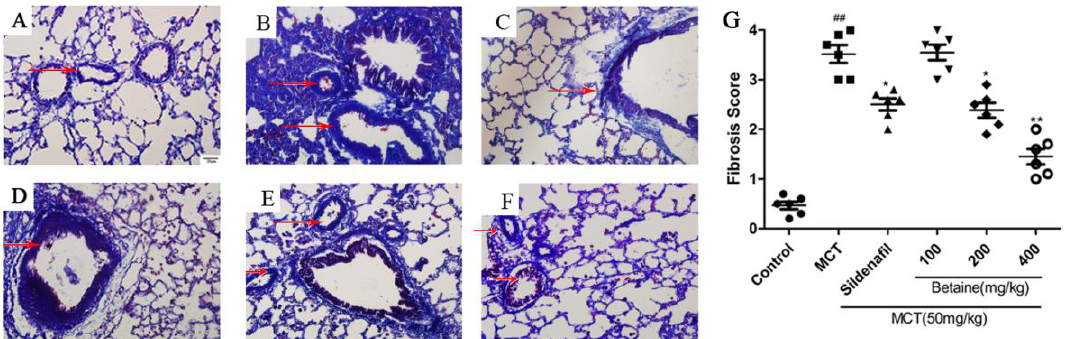
Figure 6. ( A – G ) Effect of betaine on collagen fiber hyperplasia assessed by Masson staining (magnification × 400). ( A ) Control group, ( B ) MCT group, ( C ) sildenafil group, ( D ) betaine 100 mg/kg group, ( E ) betaine 200 mg/kg group, ( F ) betaine 400 mg/kg group and ( G ) the grade of fibrosis with Masson staining. 0, no fibrosis; 1+, fibrosis present; 2+, mild fibrosis; 3+, moderate fibrosis; 4+, severe fibrosis. ## p < 0.01 vs control group; * p < 0.05, ** p < 0.01 vs. MCT